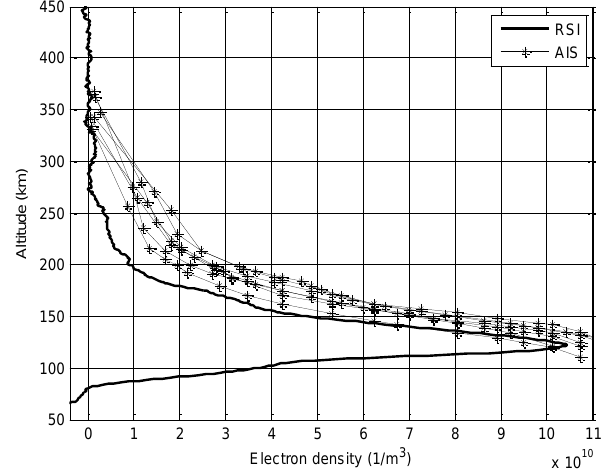
Fig. 4. Second Comparison between a profile obtained from Mars Express Radio Science (Year: 2006, DOY: 084, Latitude: 16.6432 ◦ , SZA=54.3843 ◦ , Ls=30.15 ◦ , F 10 . 7 =76) (bold line) and some top- side profiles obtained from MARSIS instrument with similar con- ditions of location, solar zenith angle, solar activity and solar longitude (Orbit: 5240, ionograms: 155–186, SZA=50–51 ◦ , Lat- itude=26–11 ◦ , Ls=25.14 ◦ , F 10 . 7 =73) (light